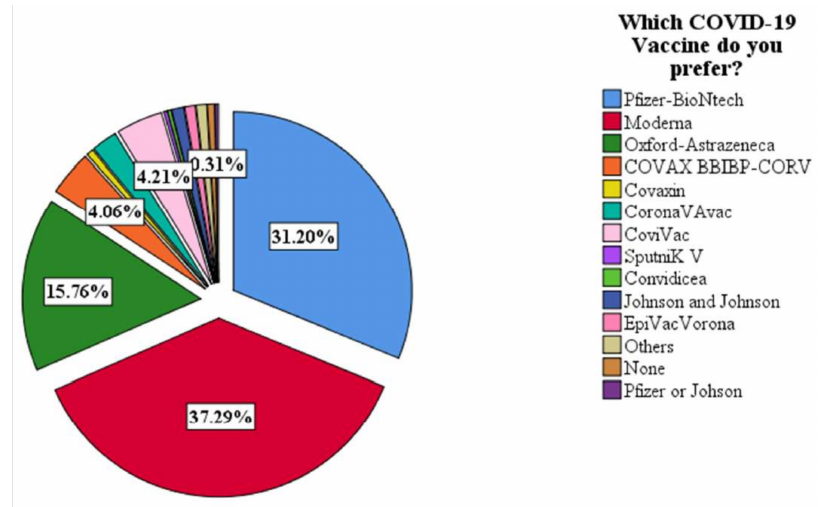
Figure 2. COVID-19 vaccine preference among HCWs.